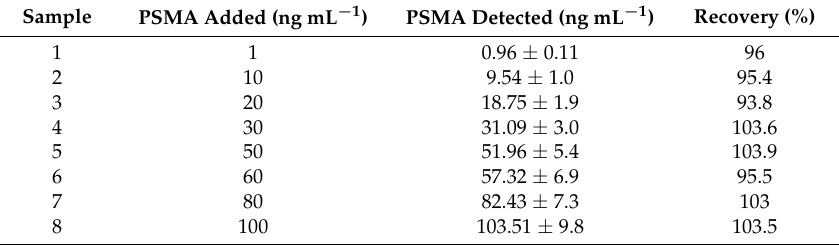
Table 1. Results of the detection of PSMA in mouse serum by our hydrophilic MIP-based Love wave sensor.